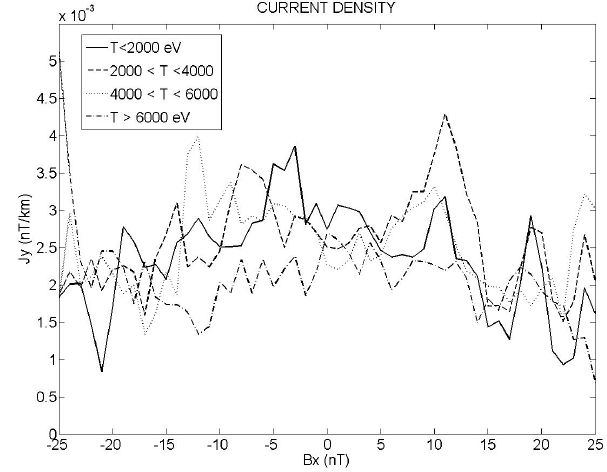
Fig. 3. Probability density for occurrence of the minimal angle ϕ between the temperature tensor eigenvector and the magnetic field vector normalized by sin ϕ .